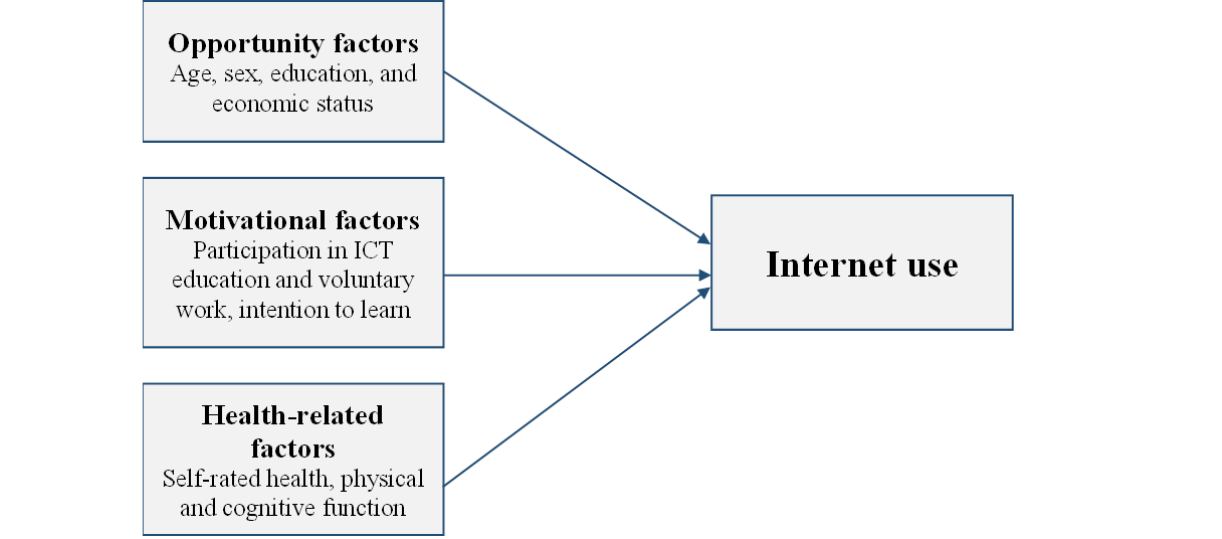
Figure 1. Factors related to internet use. ICT: information and communications